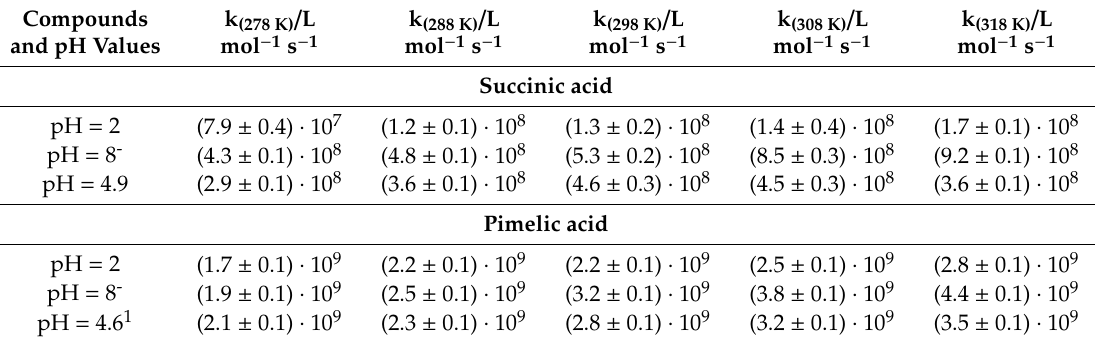
Table 1. Observed OH radical second order rate constants of the reaction with studied dicarboxylic acids at di ff erent